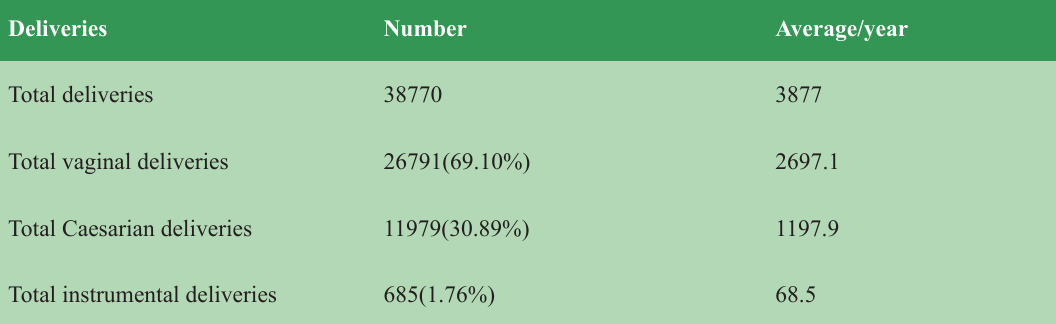
Table 1: Total vaginal and Caesarian births during the ten year